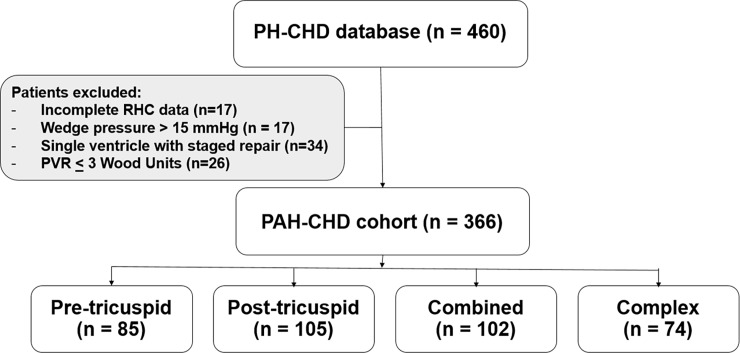
Flow of patient cases in the study.(PH, pulmonary hypertension; CHD, congenital heart disease; PAH, pulmonary arterial hypertension; RHC, right heart catheterization).